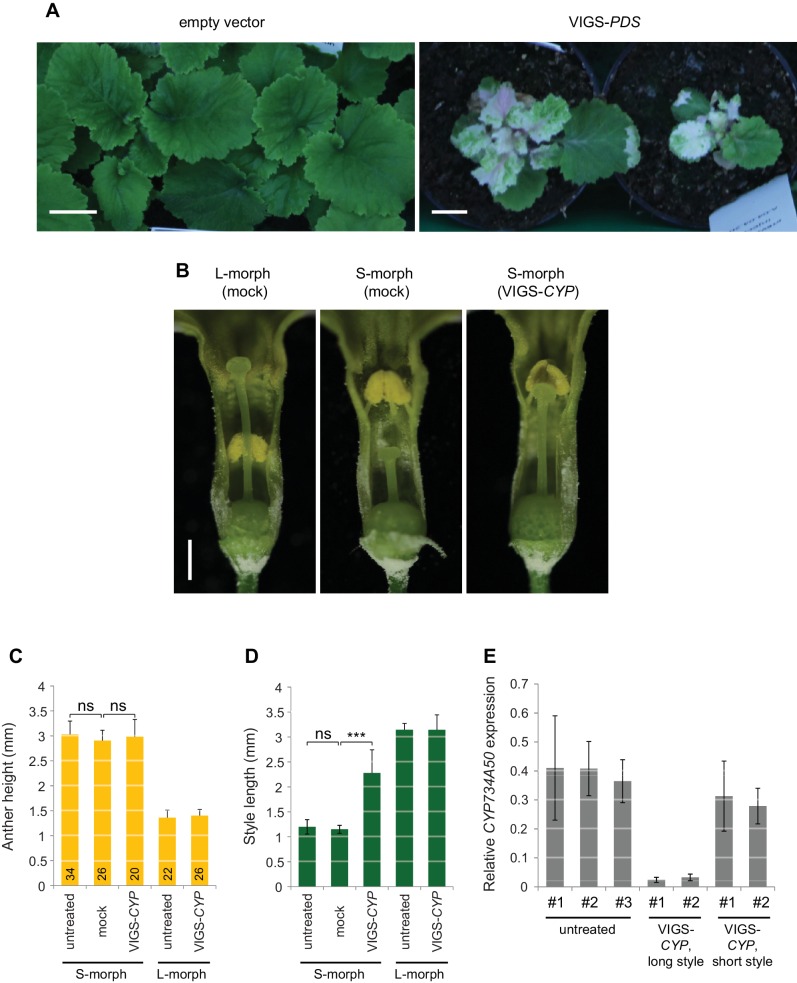
Virus-induced gene silencing in P. forbesii.(A) Phenotypes of P. forbesii seedlings injected with empty TRV-vectors as negative control (left) and with PDS-containing TRV vectors (right) showing bleaching due to silencing of phytoene desaturase (PDS) expression. No phenotypic alteration is seen in the negative control seedlings compared to untreated plants. Scale bar is 1 cm. (B) Flower phenotypes from the indicated treatments. Mock indicates injection of the inflorescence stems with water. (C,D) Anther height (C) and style length (D) of plants from the indicated treatments. Numbers of flowers for stamen and style-length measurements are indicated. Values are mean ± SD. Means of indicated samples were compared using a two-sided t-test assuming unequal variance, followed by Bonferroni correction. ***p<0.001. (E) Expression of CYP734A50 in dissected styles of plants from the indicated treatments and phenotypes as determined by qRT-PCR, normalized to α-TUBULIN. Each sample (#1, #2, etc) is derived from pooling styles of one individual plant. Values are mean ± SD from three technical replicates per sample.